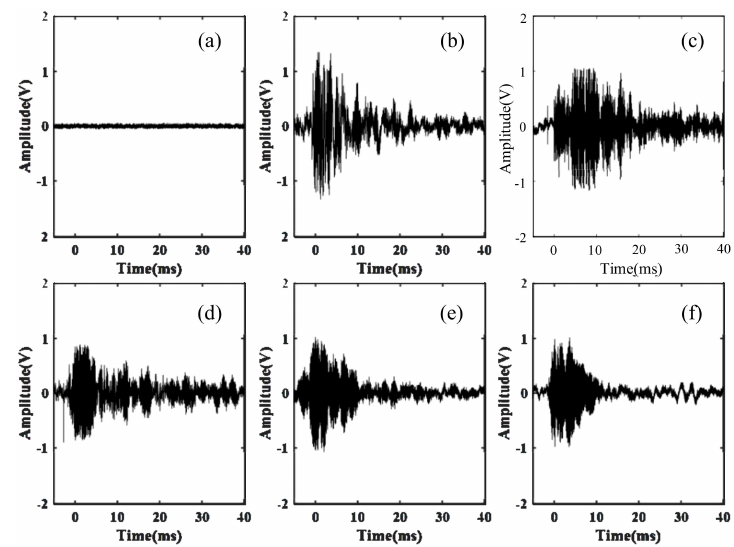
Figure 10. Time-domain waveform of PD signals at different positions. ( a ) No partial discharge event. The sensing probe is placed ( b ) on the top, ( c ) in the front, ( d ) behind, ( e ) on the left side and ( f ) on the right side of the discharge protection hood.